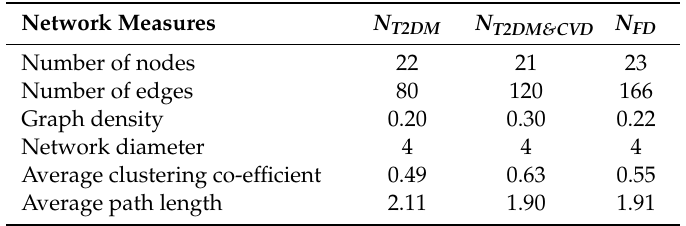
Table 7. Di ff erent network measures of three disease